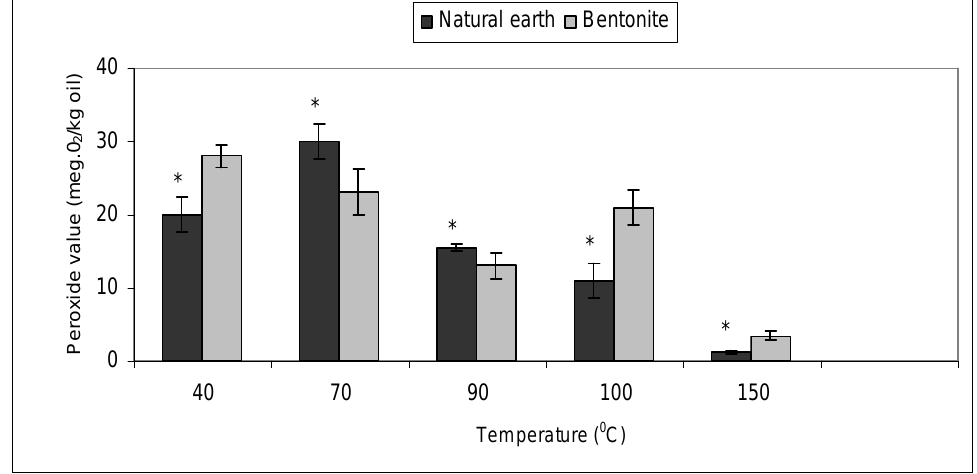
Figure 3. Effect of bleaching temperatures on crude ostrich oil using bentonite and natural earth clay in removing